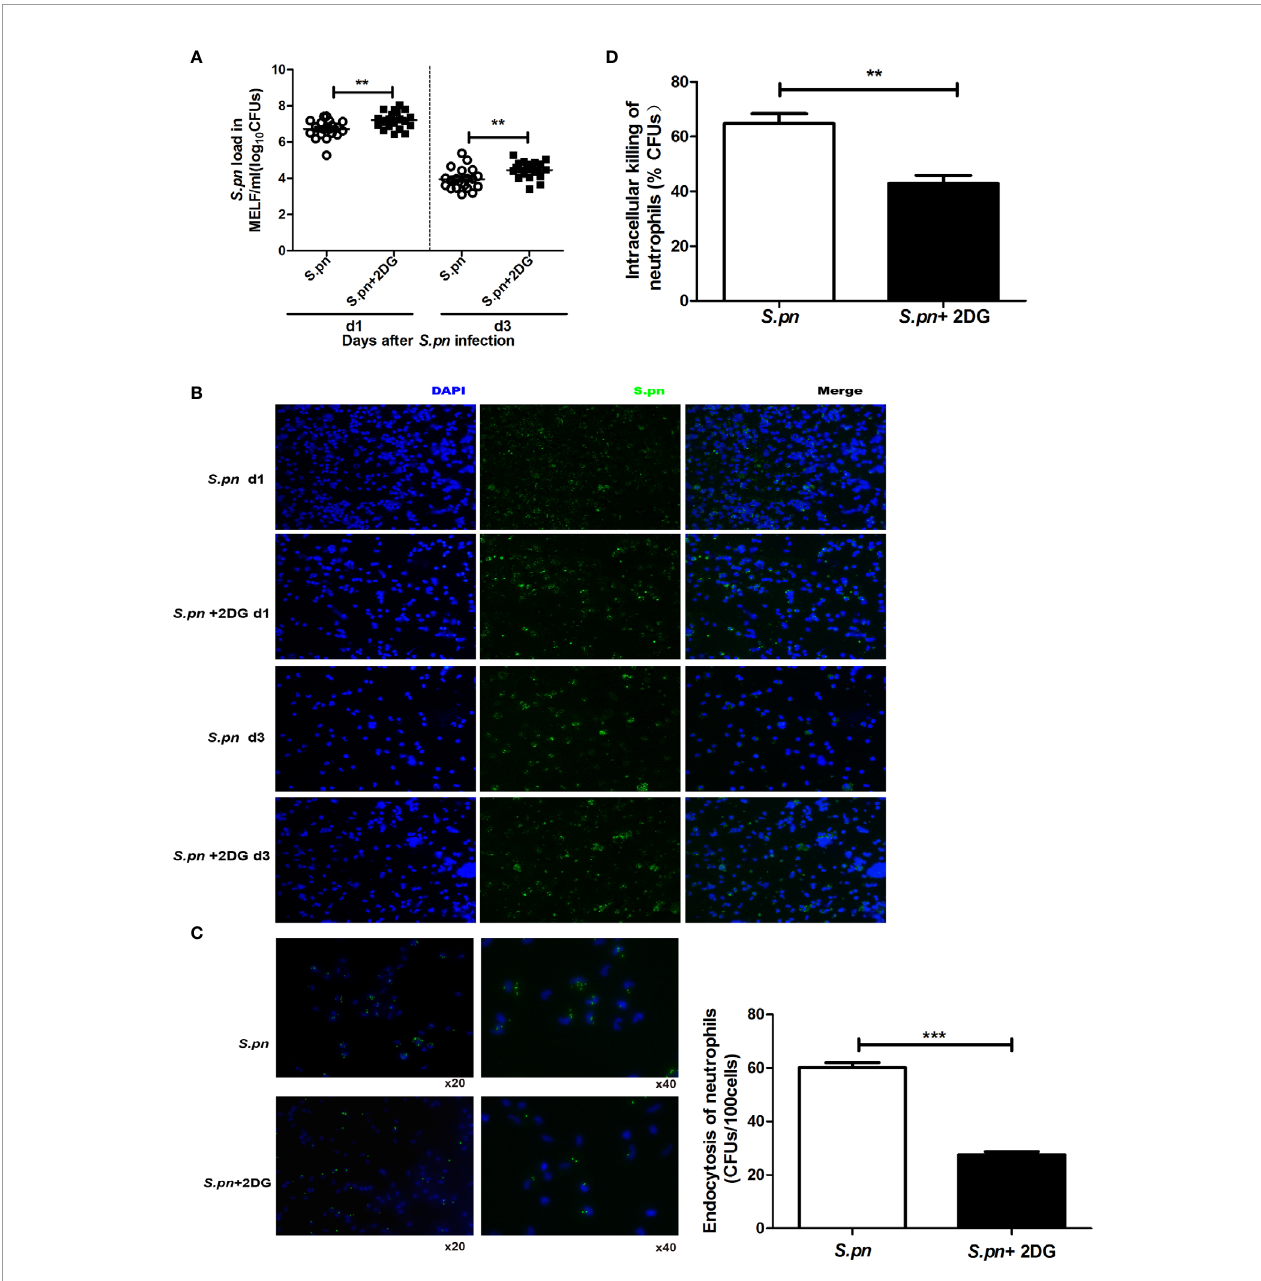
FIGURE 3 | Glycolytic pathway facilitates the clearance of S.pn . (A) S.pn. burden in MELF was counted after S.pn. ± 2DG treatment (n=18). (B) S.pn. loads in MELF were shown by immuno fl uorescence after S.pn. ± 2DG treatment. (C) Number of FITC-labeled S.pn. phagocytosed by 100 neutrophils. (D) The intracellular killing ratio of neutrophils was shown. Data represent three independent experiments and are presented as mean ± SD (n = 3). **P <.01; ***P